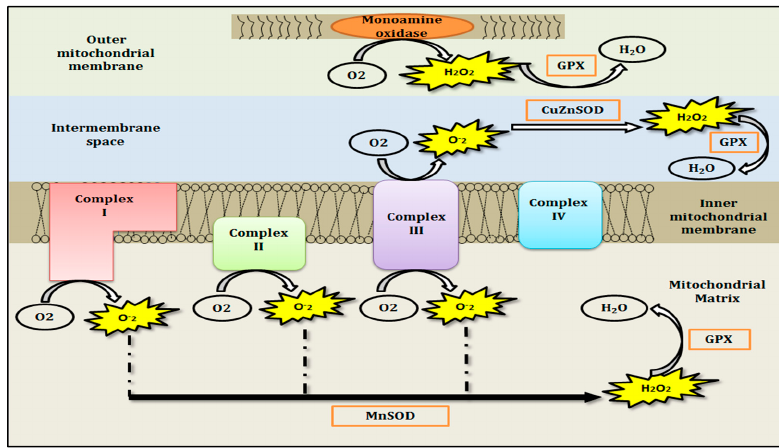
Figure 1. A schematic underlies the pathway of mitochondrial free radical generation and their enzymatic antioxidant defences. The mitochondrial